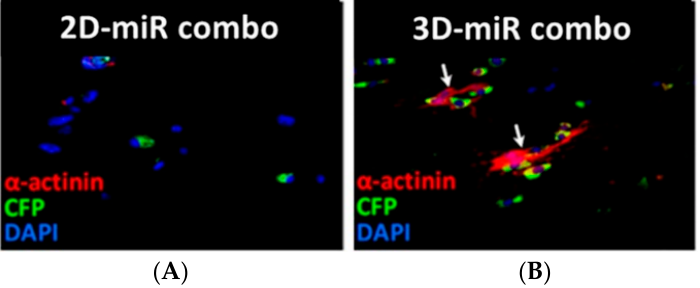
Figure 5. Representative immunostainings of neonatal cardiac mouse fibroblasts transfected with miR combo on 2D ( A ) and 3D ( B ) environment. 3D fibrin-based hydrogels (right panel) supported fibroblast reprogramming into CMs increasing α -sarcomeric actinin expression compared to 2D culture (left panel) after 14 days culture time. Reproduced from Li et al. [110].